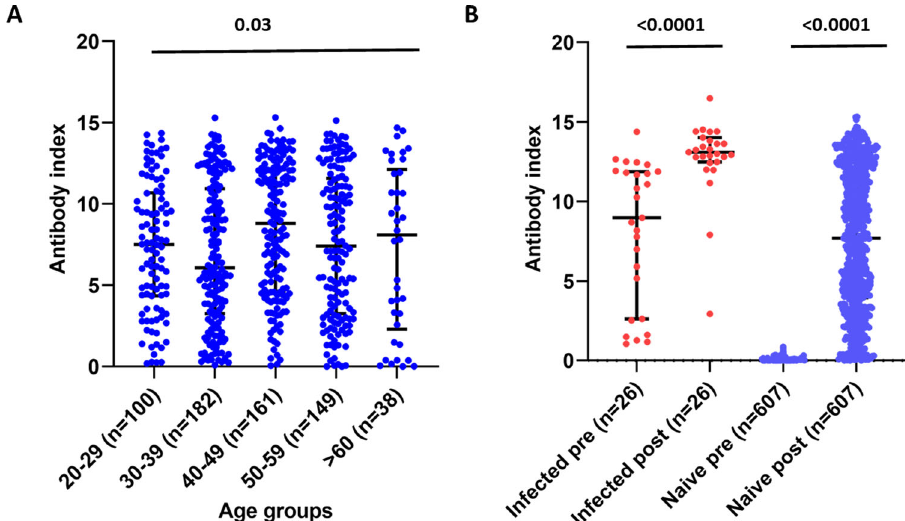
Fig. 1 SARS-CoV-2-speci fi c total antibody levels in vaccinated individuals. SARS-CoV-2 total antibody levels (antibody index) in those in different age groups ( n = 629) ( A ), and the total antibody levels in those who had previous infection at baseline and 28 – 32 days after a single dose ( n = 26), and in SARS-CoV-2 uninfected individuals at baseline and 28 – 32 days after a single dose ( n = 629) ( B ) were measured using the WANTAI SARS-CoV-2 Ab ELISA assay. The Kruskal – Wallis test was used to compare the differences in the antibody titres (antibody indexes) in each age group and the Wilcoxon matched-pairs signed-rank test was used to compare the means of the antibody indexes, before and after the vaccine. All tests were two sided. Data are presented as median values ± interquartile ranges as